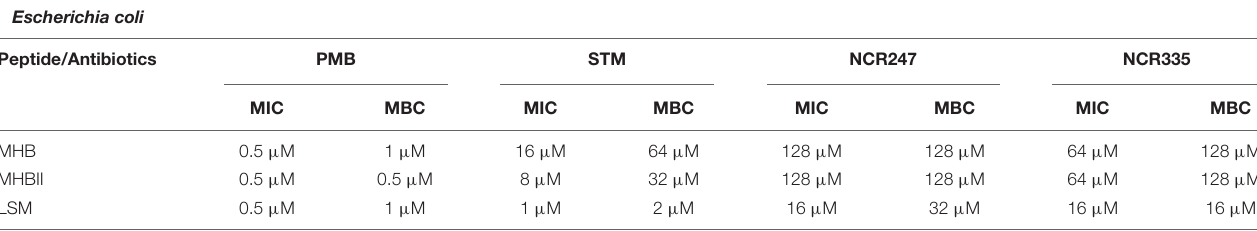
TABLE 1 | Minimal inhibitory concentration (MIC) values determined by colorimetric assay (resazurin) and minimal bactericidal concentrations (MBC) determined by conventional plating method on E. coli . Escherichia coli Peptide/Antibiotics